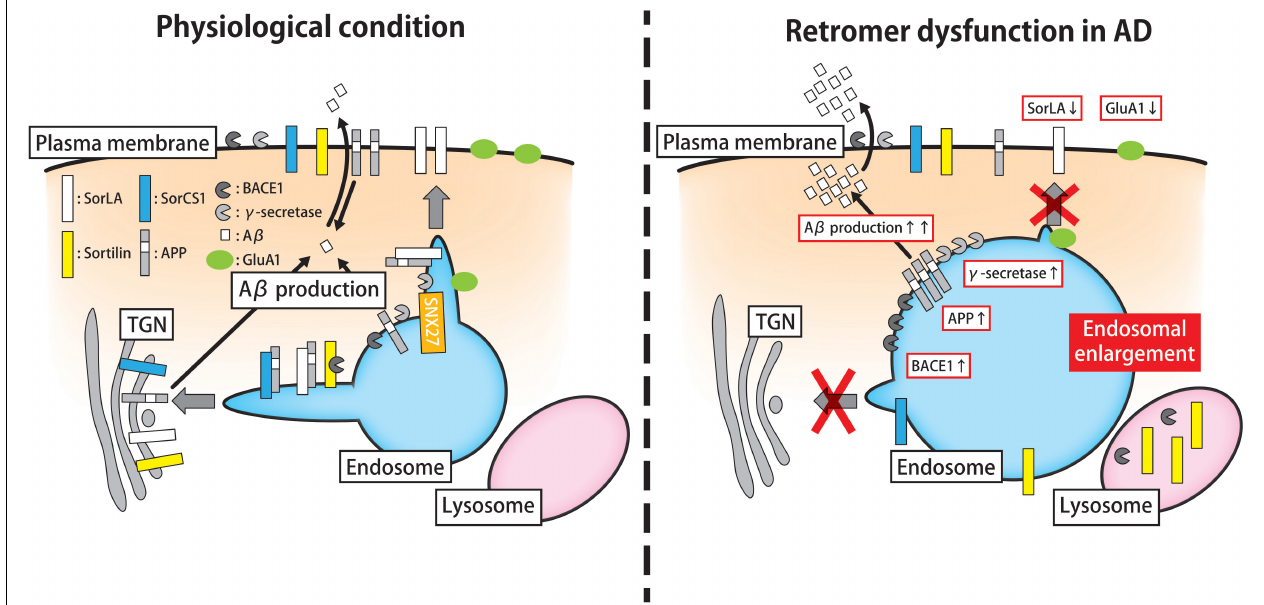
FIGURE 2 | Roles of the retromer machinery in the trafficking and metabolism of AD-related proteins. Endosomal trafficking plays a key role in the processing of APP and the biogenesis of A β peptides. Under physiological conditions ( left panel ), the A β peptide is synthesized through the proteolytic cleavage of APP by BACE1 (also known as β -secretase) and γ -secretase on the plasma membrane, early endosomes, and TGN. Retromer complex contributes to the retrograde transport of APP, BACE1, γ -secretase, and related proteins (e.g., SorLA and SorCS1) from endosomes. The SorLA-mediated transport of APP to the plasma membrane requires the support of SNX27. In addition to the endosomal pathway, the retromer might participate in surface recycling of the AMPAR subunit GluA1, thereby modulating synaptic plasticity. In AD brains, in which retromer function is compromised ( right panel ), APP, BACE1, γ -secretase, and associated proteins accumulate in early endosomes, thereby increasing A β production with hypertrophic changes in endosomal compartments. Besides the amyloidogenic pathway, retromer malfunction perturbs the cell surface recycling of GluA1, which may influence on synaptic plasticity. APP, amyloid precursor protein; A β , amyloid- β ; BACE1, β -APP-cleaving enzyme-1; TGN, trans -Golgi network; SNX sorting nexin; AMPAR, α -amino-3-hydroxy-5-methyl-4-isoxazole propionate receptor; AD, Alzheimer’s